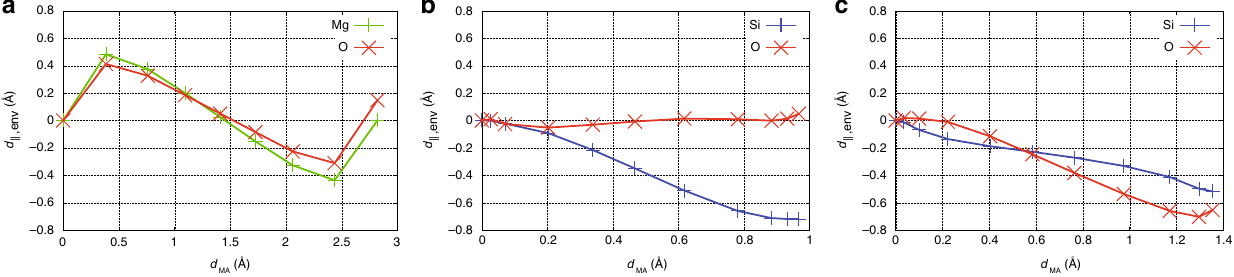
Fig. 2 Environment atom displacement along defect migration path. Projection of the total net displacement of environment atoms (for each environment species) along the MA displacement vector as a function of the MA net displacement for, respectively, V 2 þ projection is computed as d ð I Þ number of